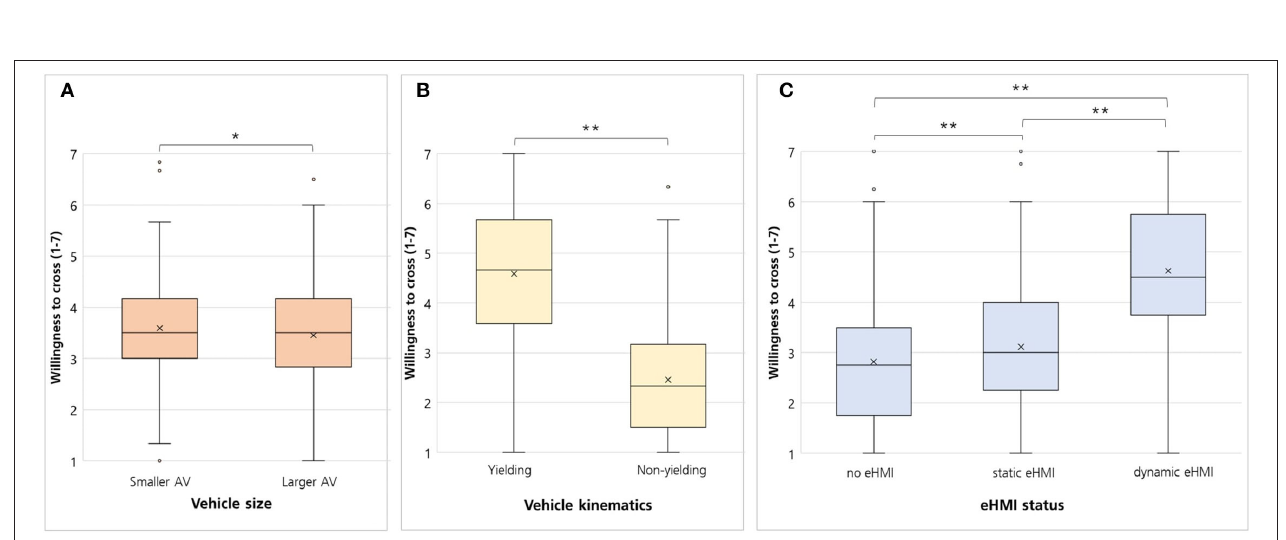
FIGURE 4 | Boxplots for pedestrians’ willingness to cross focusing on the variables (A) vehicle size (smaller vs. larger AV), (B) vehicle kinematics (yielding vs. non-yielding), and (C) eHMI status (no eHMI vs. static eHMI vs. dynamic eHMI). Crosses = means; lines = medians; ** p < 0.001 * p < 0.01.